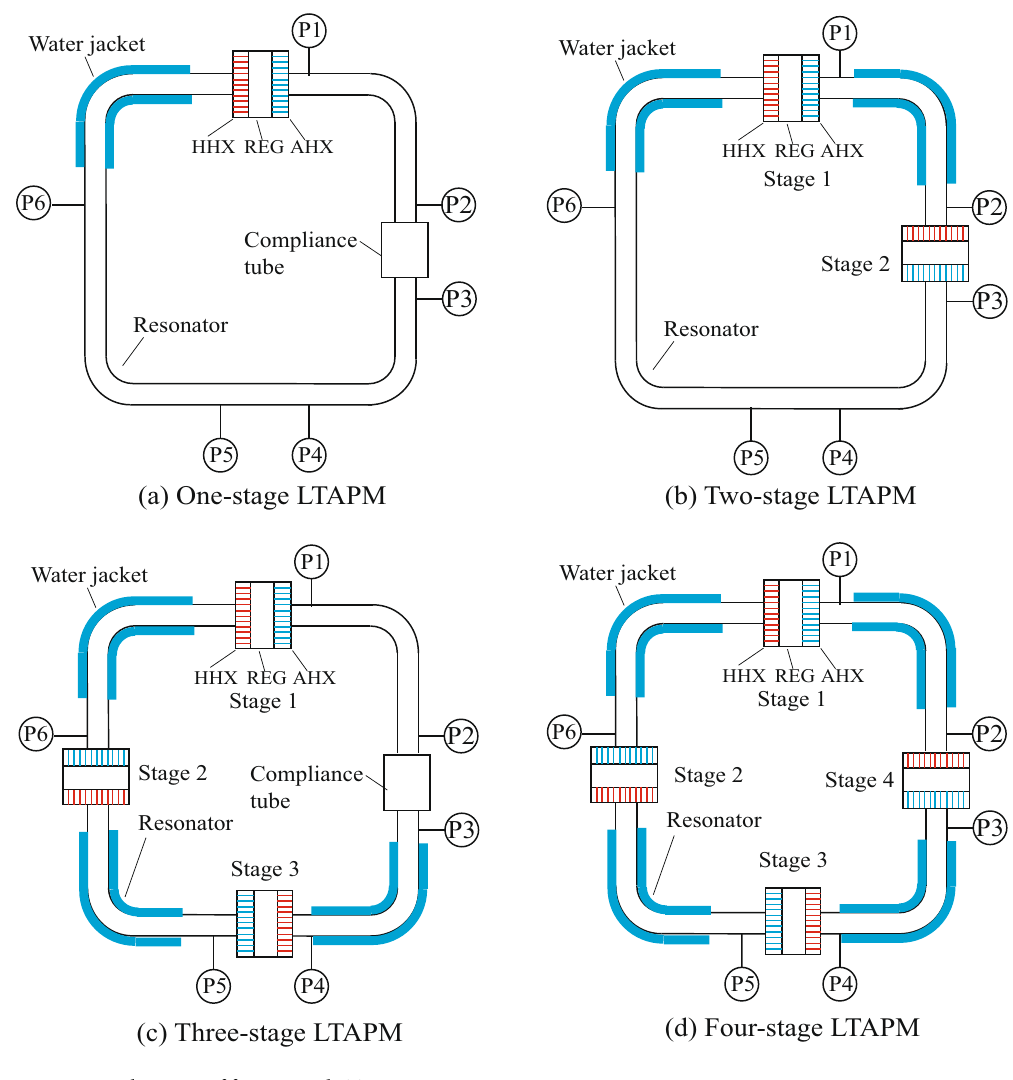
Figure 1. Schematic of four typical